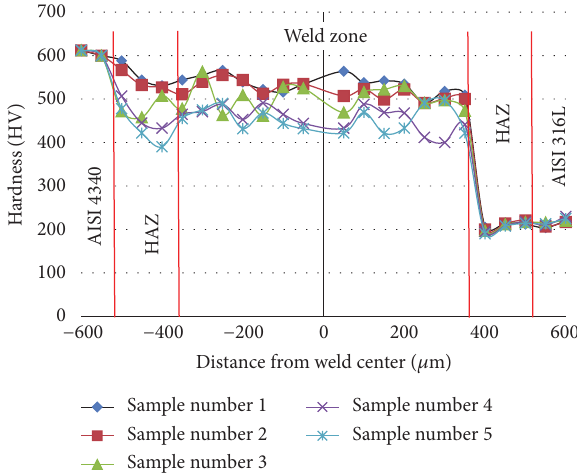
Figure 7: The profile from hardness tests for EBW weld samples.